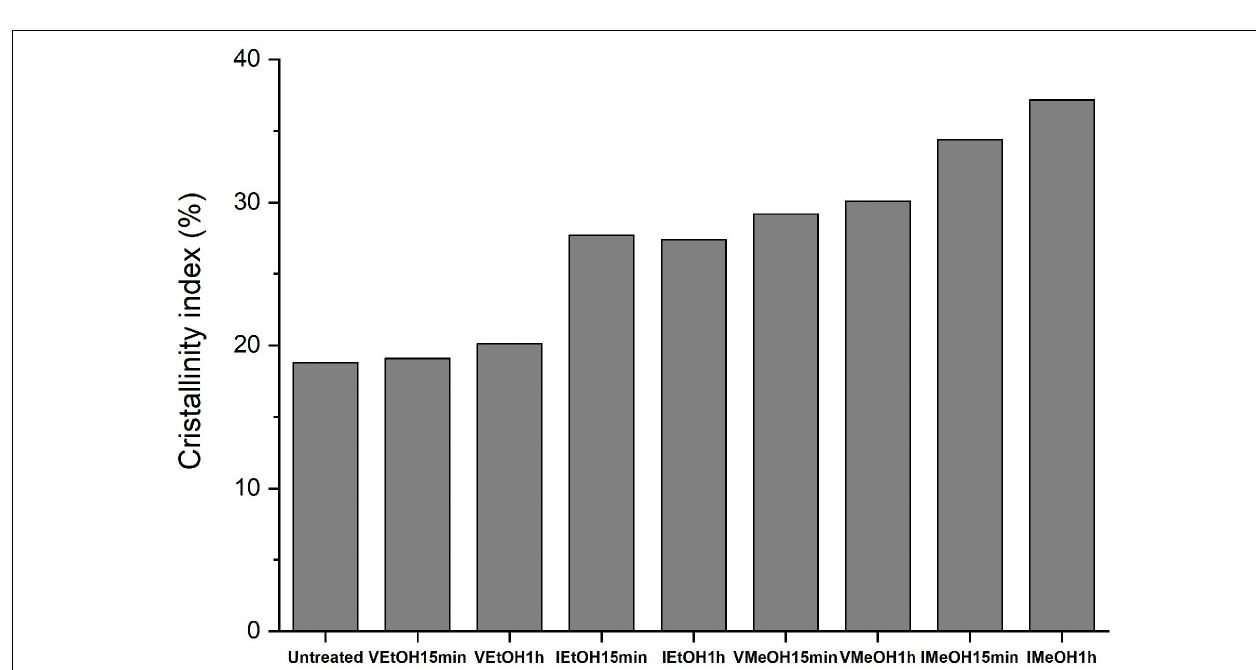
FIGURE 4 | XRD crystallinity index of untreated and treated